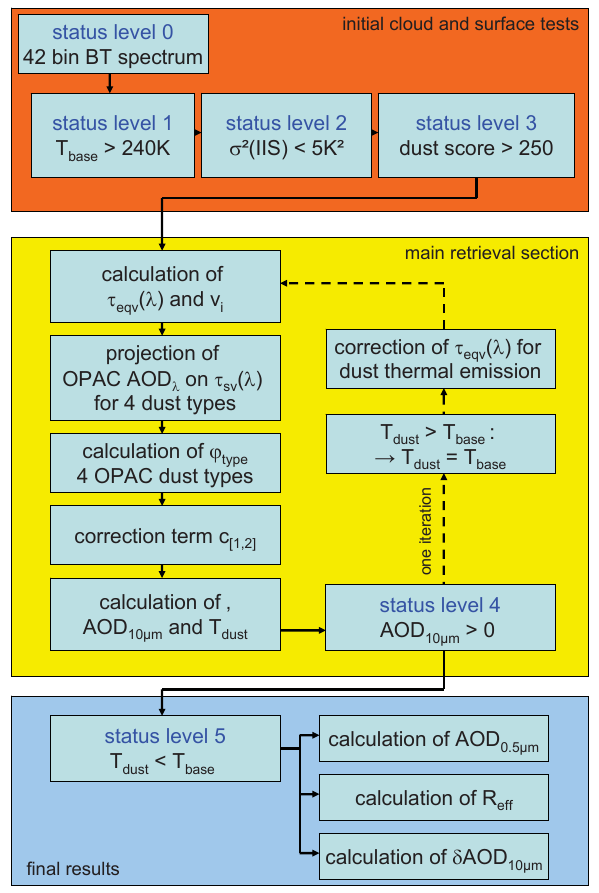
Fig. 1. Algorithm flowchart of the consecutive steps performed in the IASI dust retrieval. The status level provides an additional information about which step or test failed when no dust AOD is retrieved. 30